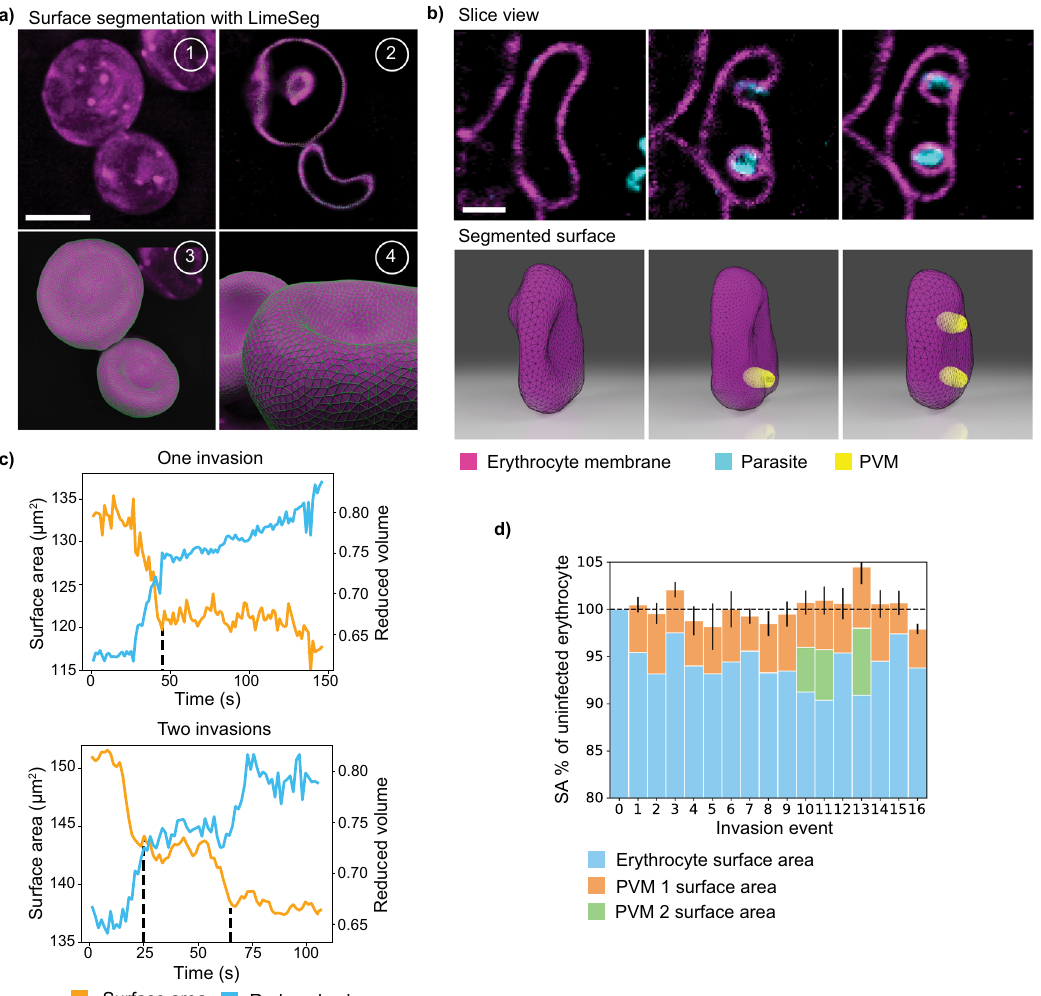
Fig. 2 The PVM is predominantly composed of host cell material as revealed by surface segmentation and analysis. a Representative images showing the process of surface segmentation on erythrocytes using LimeSeg 36 . Panels represent the (1) maximum intensity projection (MIP), (2) mid-slice, and (3 – 4) segmented surface of two uninfected erythrocytes. Scale bar: 5 µ m. b An erythrocyte invaded by two parasites. XY mid-slices showing pre-invasion, fi rst invasion, and second invasion of the erythrocyte followed by the segmented surfaces of the host erythrocyte and the two distinct PVMs. MIP and mid- slice images were displayed using ImageJ/FIJI and 3D views were created with Blender. Scale bar: 2 µ m. c Temporal tracking of the host erythrocyte membrane surface area and reduced volume during invasion. Examples of invasion by one and two parasites are displayed, with the dashed line marking the time where the parasite is fully internalized. d Surface area measurements of infected erythrocytes and their respective PVMs, each normalized to the surface area of the erythrocyte before invasion ( n = 16). Error corresponds to the standard deviation (SD) of the mean erythrocyte surface area, taken from fi ve pre-invasion frames, added with the SD of the cumulative surface area of the erythrocyte and the PVMs, taken from fi ve post-invasion frames. The analysis shown here was performed on data from four independent